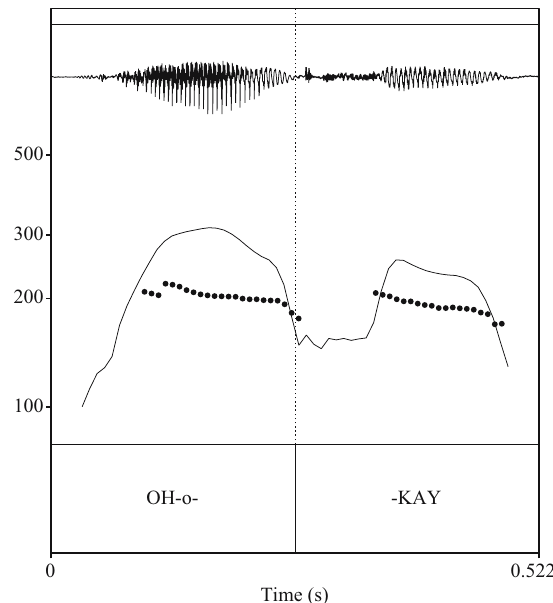
Figure 6: Pitch trace and intensity curve for line 19 in Ex ( 10 ) “ Plastic container ” .